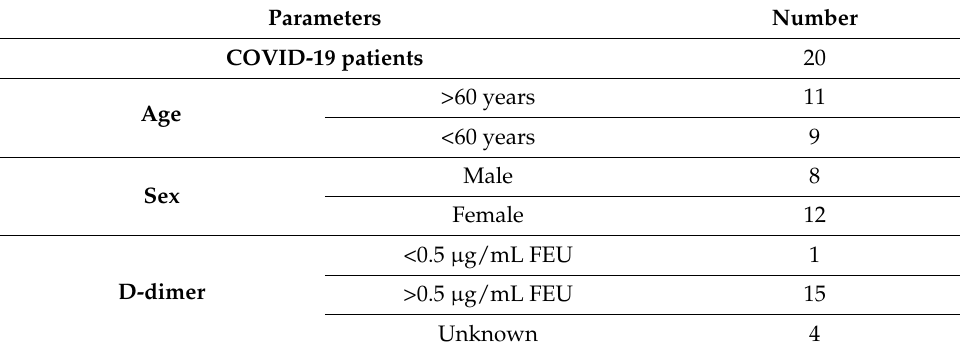
Table 1. Sample information from COVID-19 patients.